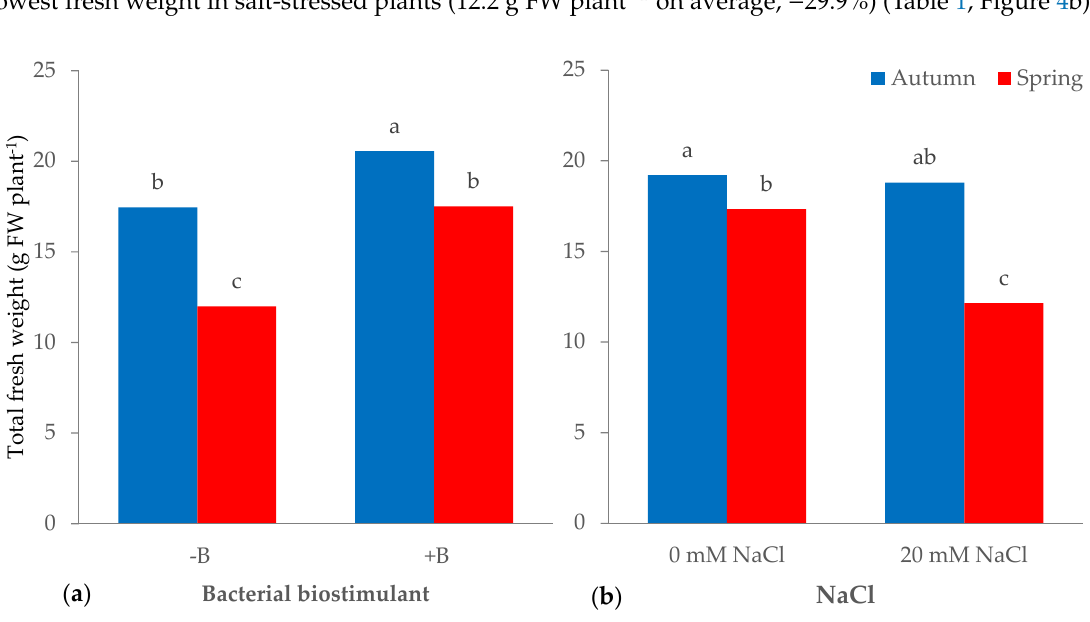
Figure 4. Total fresh weight of leaf lettuce plants grown during autumn and spring in nutrient solutions ( a ) with ( + B) or without ( − B) bacterial biostimulant or ( b ) containing di ff erent levels of NaCl (for each interaction, bars with di ff erent letters are significantly di ff erent at p < 0.05, according to the LSD test).